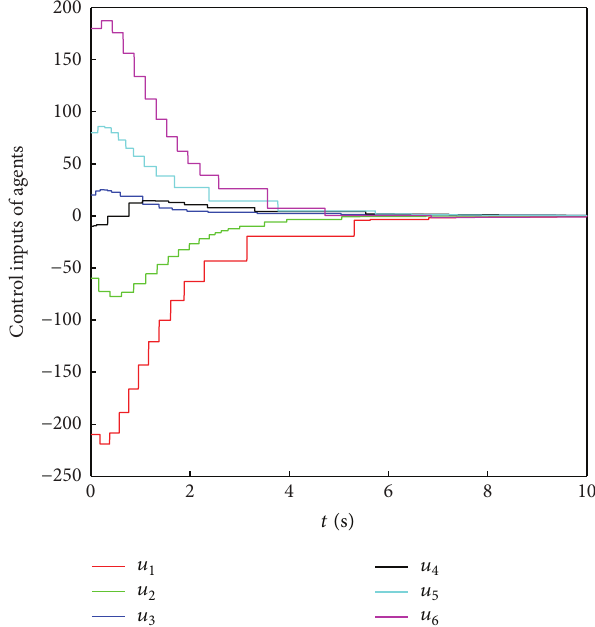
Figure 4: Control inputs of each agent with double-integrator